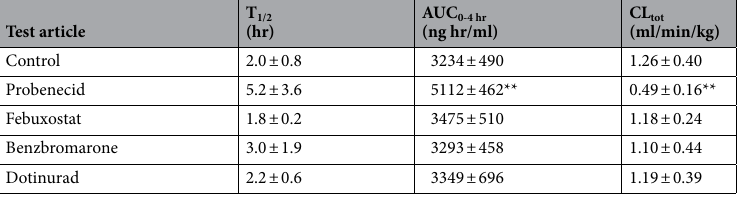
Table 4. Pharmacokinetic parameters of d 4 -IS in adenine-induced acute renal failure rats. T 1/2 : half-life, AUC 0-4 hr : area under the curve from 0 to 4 h, CL tot : total clearance. Data were analyzed using Phoenix WinNonlin 6.4 software (Certara, L.P., Princeton, NJ). Each value is presented as mean ± SD of five to six animals. ** P < 0.01, significantly different from the control group according to Dunnett’s multiple comparison